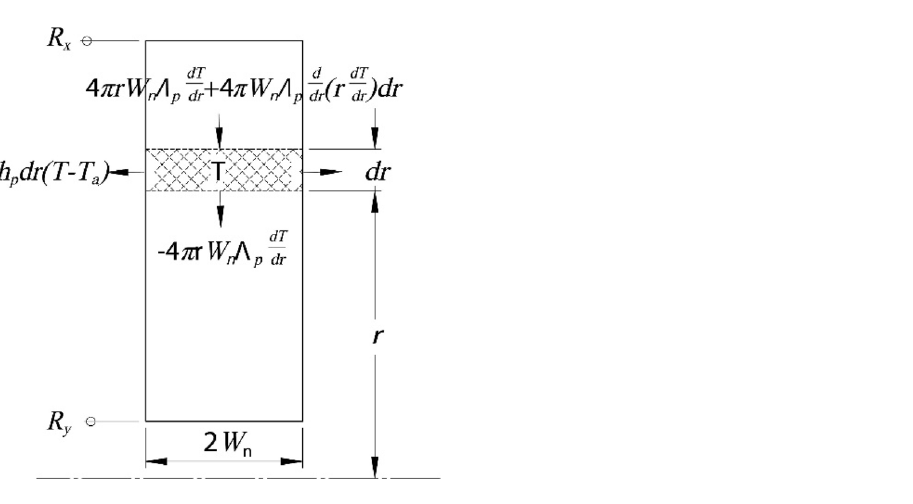
Figure 6. Thermal behavior at one cross